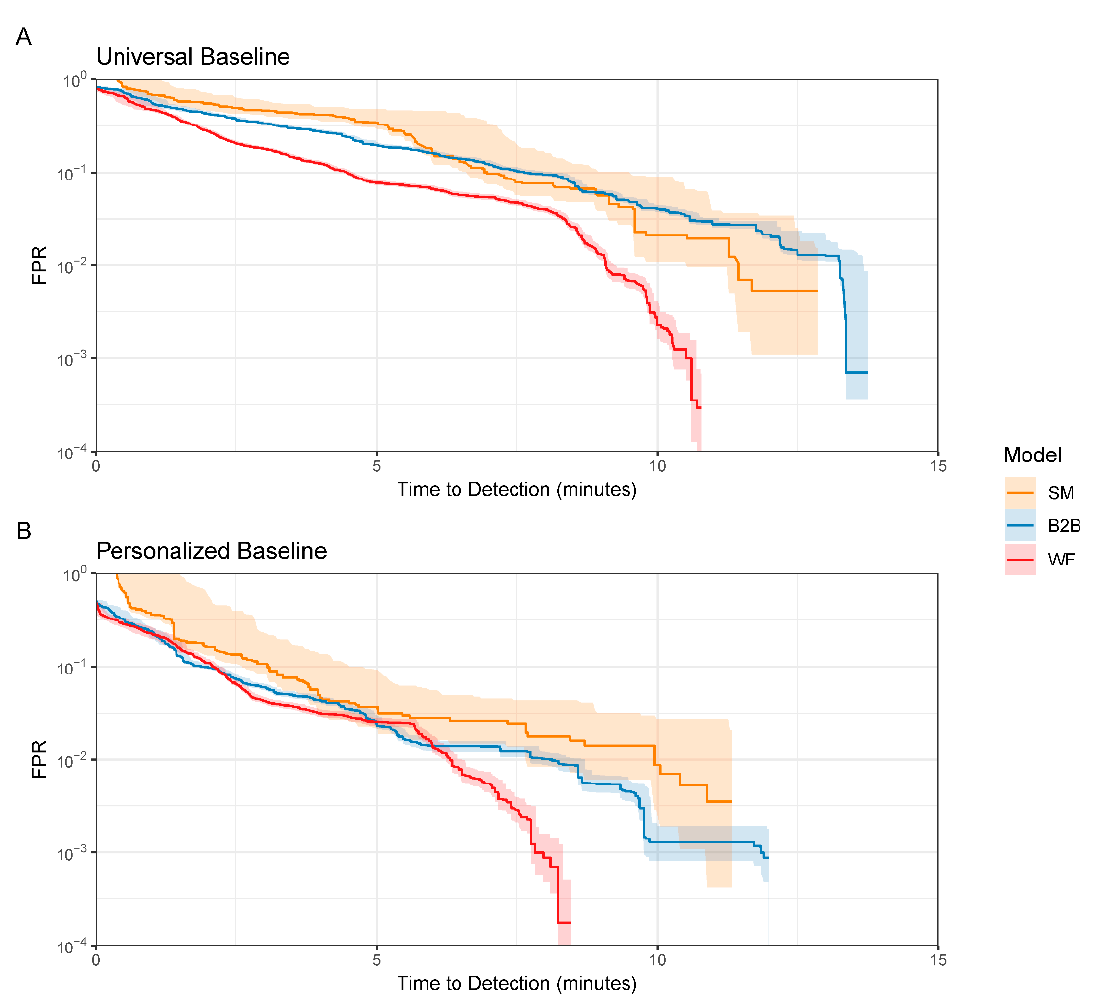
Figure 2. Activity monitoring operating characteristic analysis of models developed with increasingly granular arterial pressure physiologic data, for models developed using a universal baseline ( A ), and models developed using a personalized baseline ( B ) (see text for details). Displayed as the time to detection of bleeding versus false-positive rate for arterial catheter data only for increasing granularity levels: simple metrics (SM), beat-to-beat (B2B), and waveform (WF). Data displayed with shading equal to 95% confidence range. Data derived from Pinsky et al. [41].